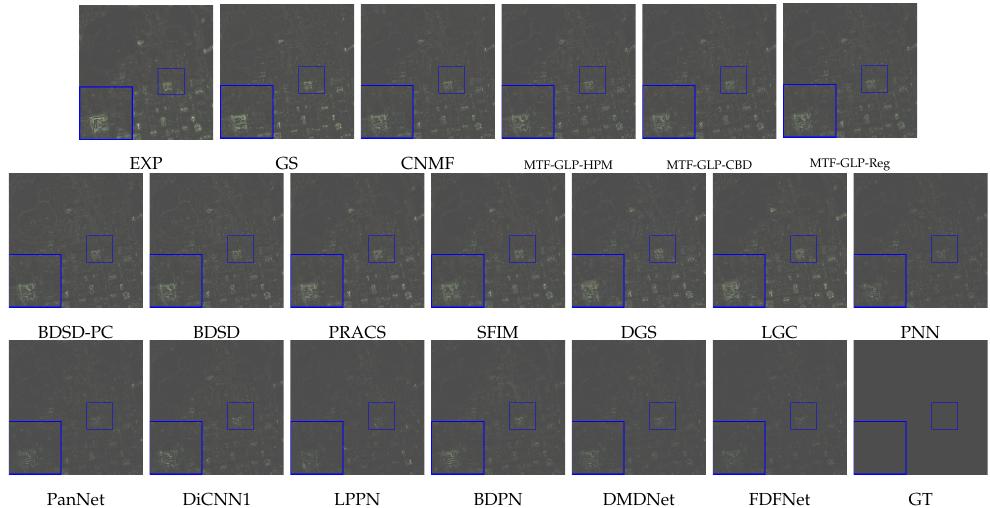
Figure 9. The visual comparisons of the corresponding residual maps using the GT image as reference (shown by bands: 1, 3, and 5).